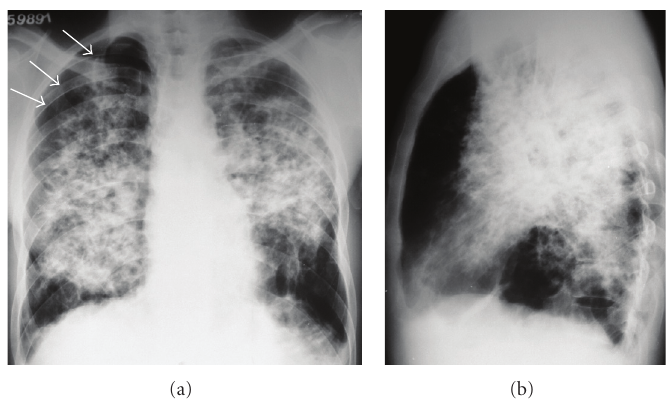
Figure 1: Chest radiographs in anteroposterior (a) and lateral (b) incidences showing a small right pneumothorax (arrows), and bilateral nonhomogeneous opacities, predominantly in the middle third of both lungs, with posterior predominance. Emphysematous areas are seen in the lung bases.